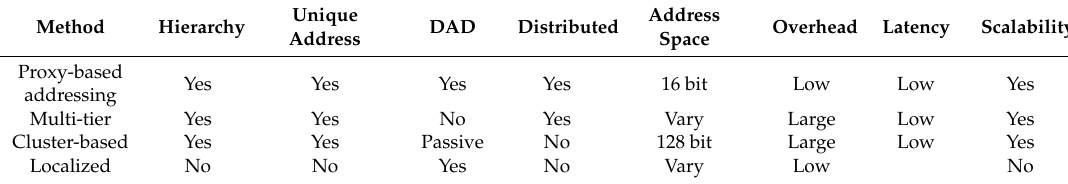
Table 1. Summary of the address auto-configuration.